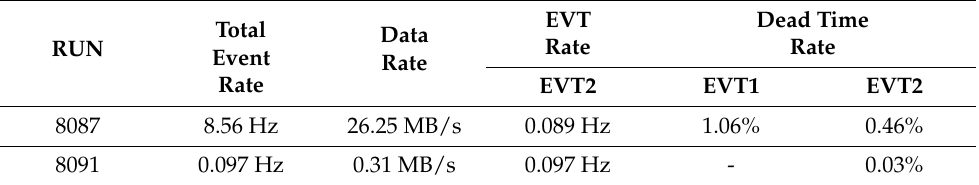
Table 3. Two run statistics with general configuration: Single Searching Mode, 24 h, buffer priority for beta decay events, at least 2 PMT hits in a Coincidence Window of 1.2 µ s, no data compression applied. RUN 8087 is set for two type of S 2 events ( 83m Kr and beta decay events) and RUN 8091 is set for one type of S 2 events (beta decay